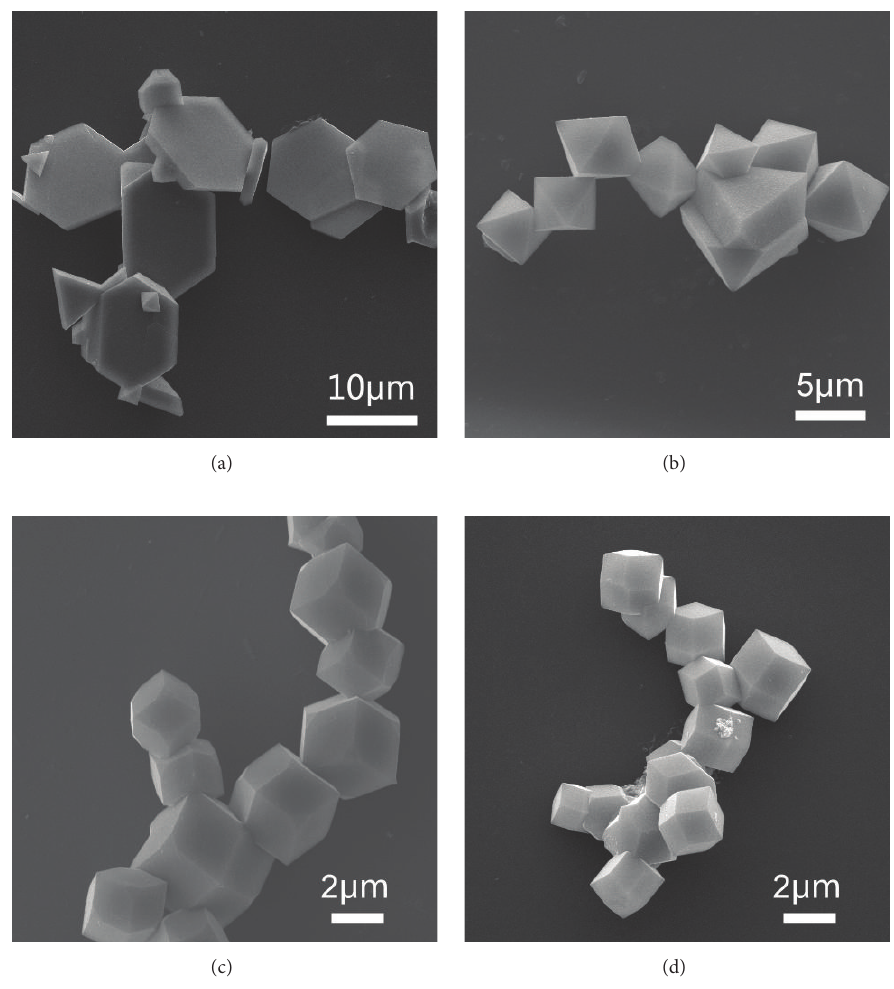
Figure 4: SEM images of samples obtained using different N 2 H 4 ⋅ H 2 O dosages at pH = 9 in the solution: (a) 0.8 mL, (b) 1.1mL, (c) 1.5 mL, and (d) 2.5 mL.